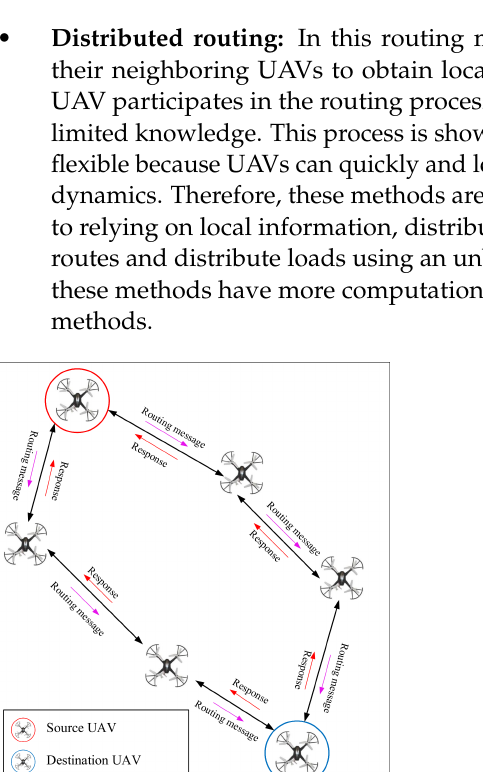
Figure 20. Centralized routing scheme.